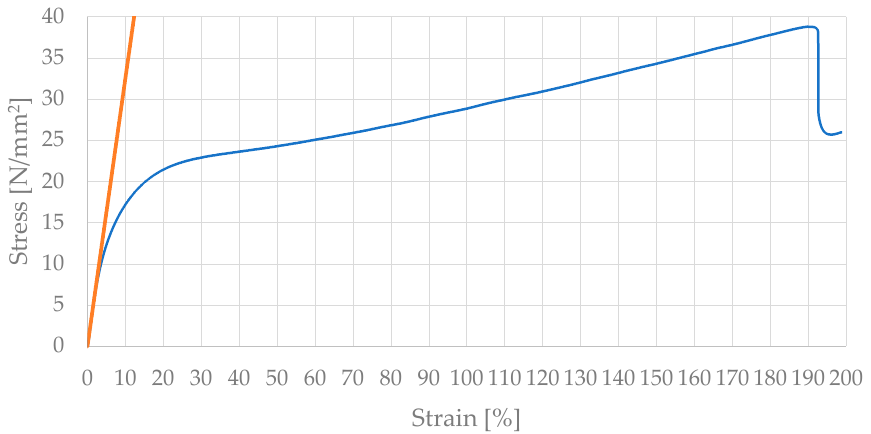
Figure 11. The stress–strain curve obtained from tensile testing data. ( blue ) True stress–strain curve. ( orange ) Hypothetical straight line of pure elastic behavior of the material.